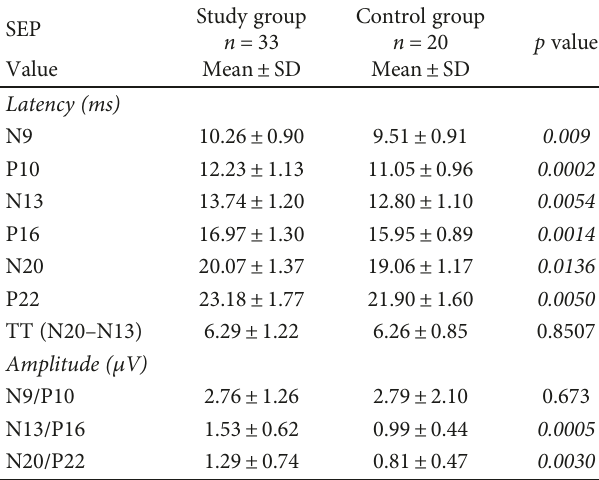
Table 3: SEP latency and amplitude in pSS patients and in the control group. These are signi fi cant where p value < 0.005 (Bonferroni